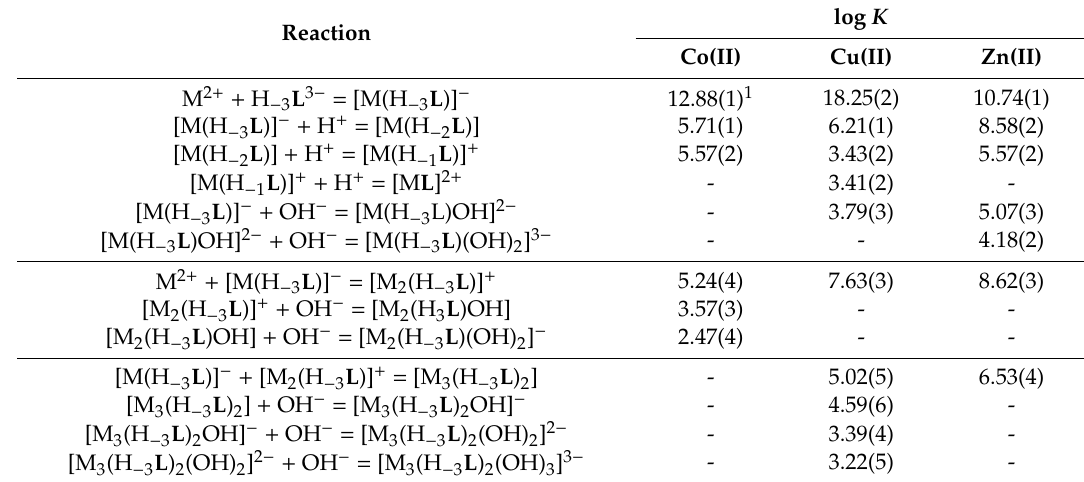
Table 3. Equilibrium constants (log K ) for the metal complex equilibria of L2